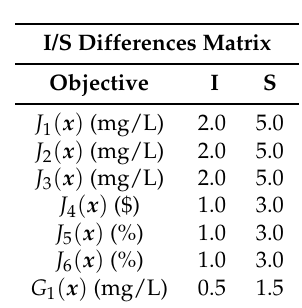
Table 7. Matrix with (in)significant differences for MOP II statement. Significant (S) and Insignificant (I) differences for each design objectives are defined.